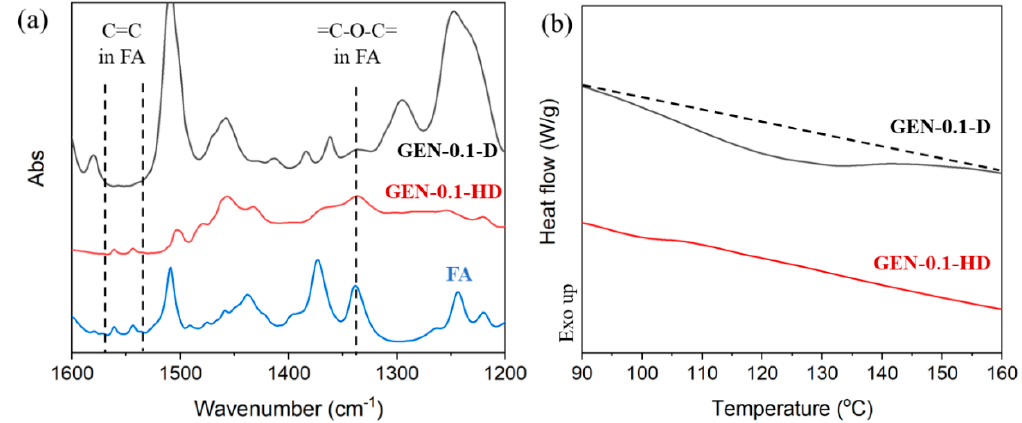
Figure 3. FT-IR spectra ( a ) and DSC thermograms ( b ) of GEN-0.1-D and GEN-0.1-HD.